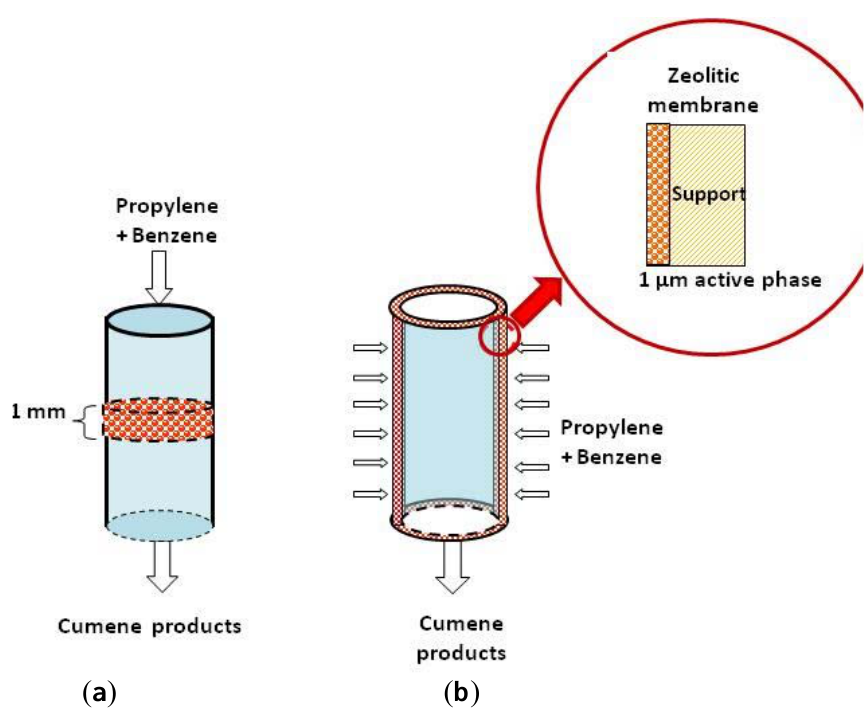
Figure 2. X-ray diffraction pattern of the β -zeolite and the β -zeolite membrane (SiO